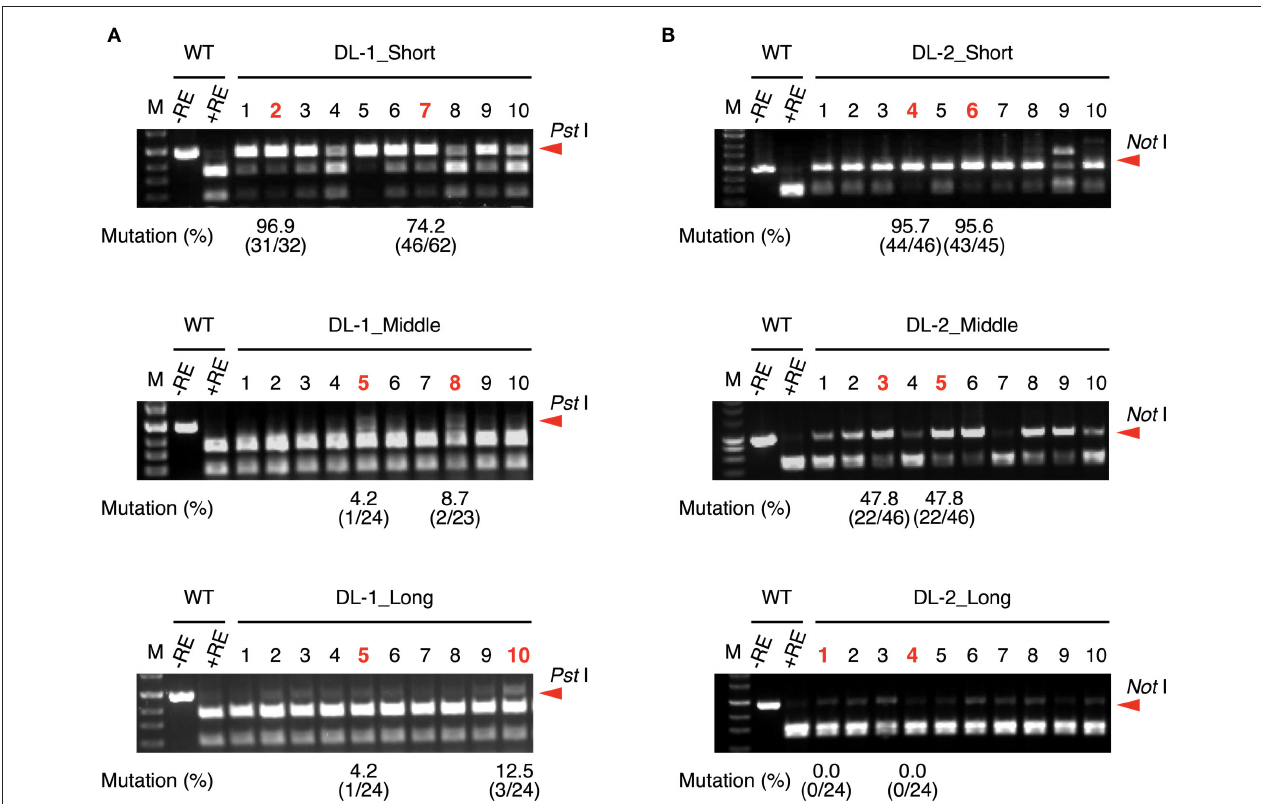
FIGURE 1 | CAPS analysis and mutation frequency using crRNA with guide sequences of different lengths at DL-1 (A) and DL-2 (B) target sites. Mutation frequencies of selected calli (shown in red) were calculated from the ratio of sequenced clones with mutation. M, DNA molecular weight; –RE, without restriction enzyme; + RE, with restriction enzyme. Red arrowheads indicate the position of undigested PCR